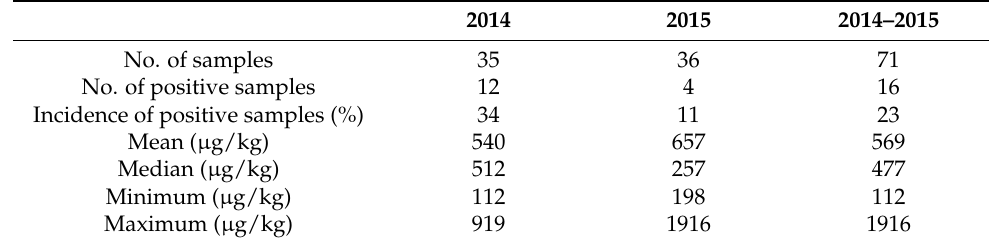
Table 1. Occurrence of deoxynivalenol (DON) in the wheat samples from the harvesting seasons 2014 and 2015.